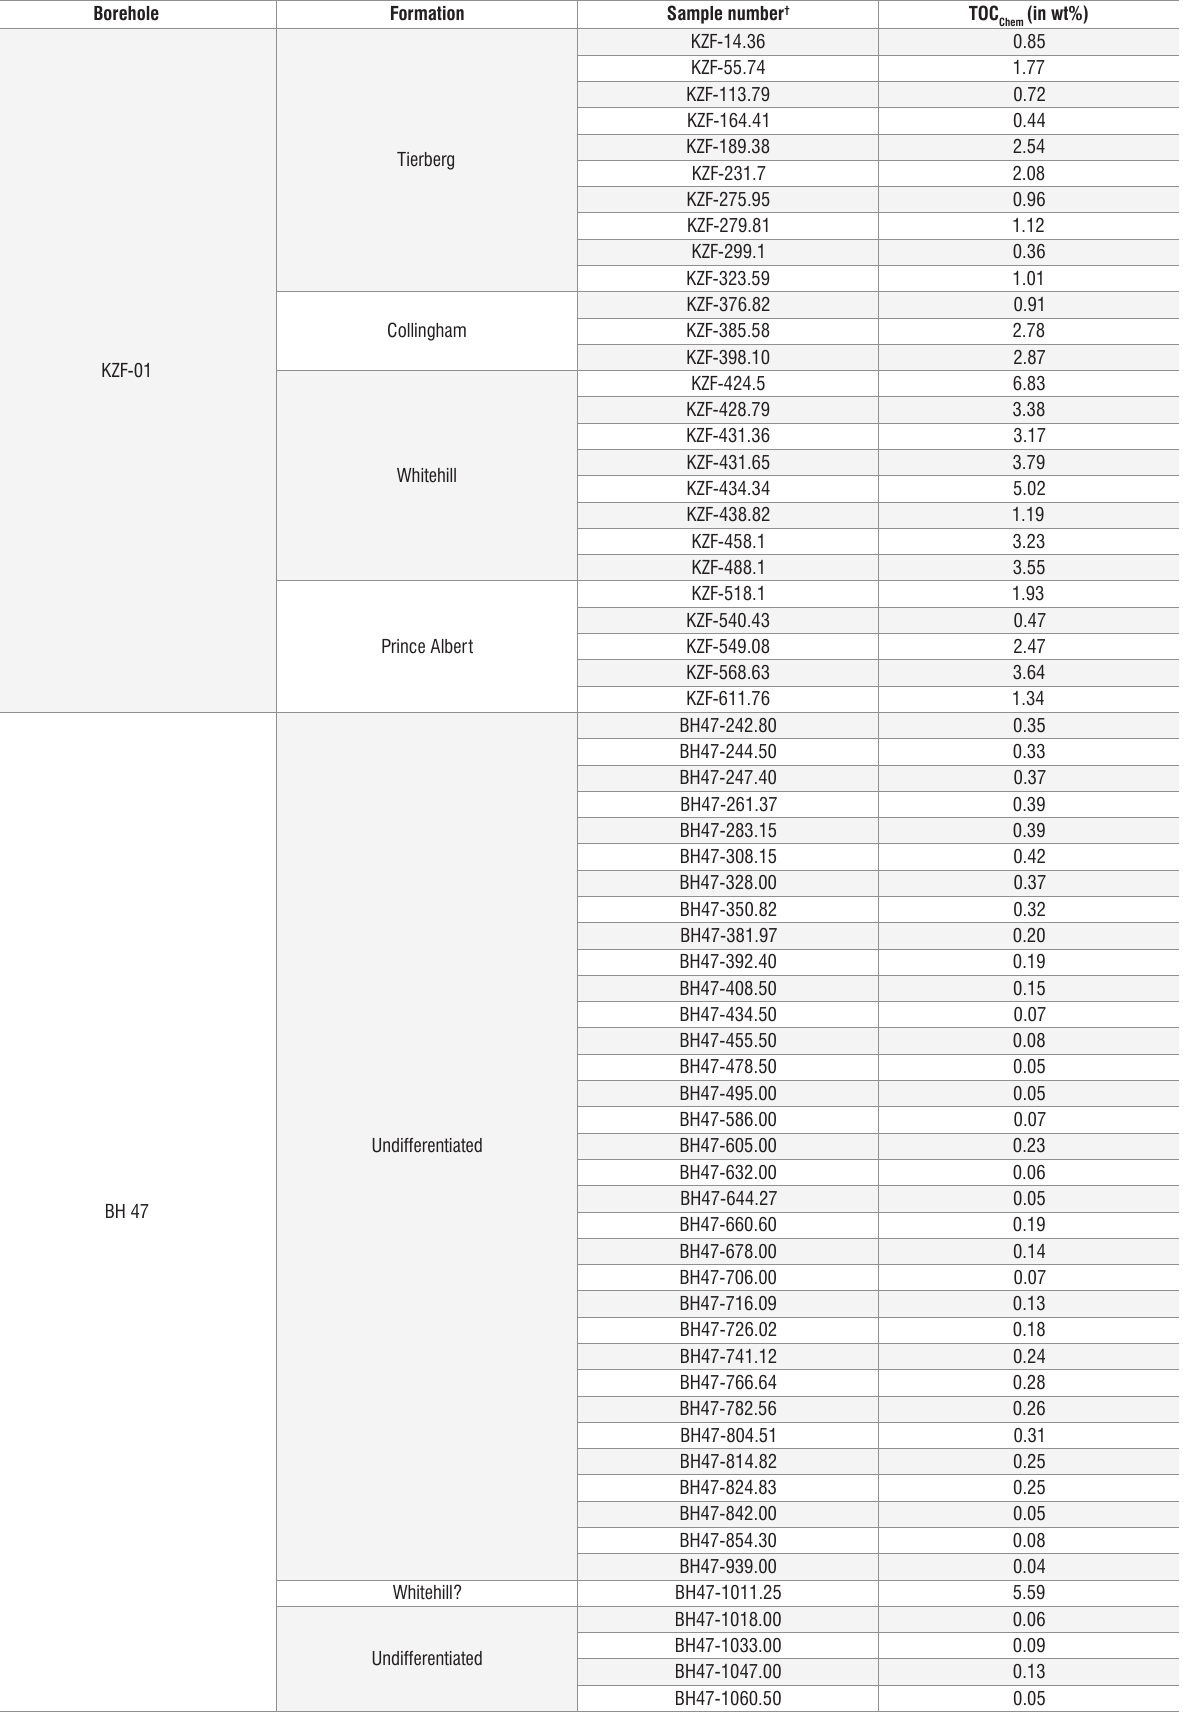
) content of shale samples chem